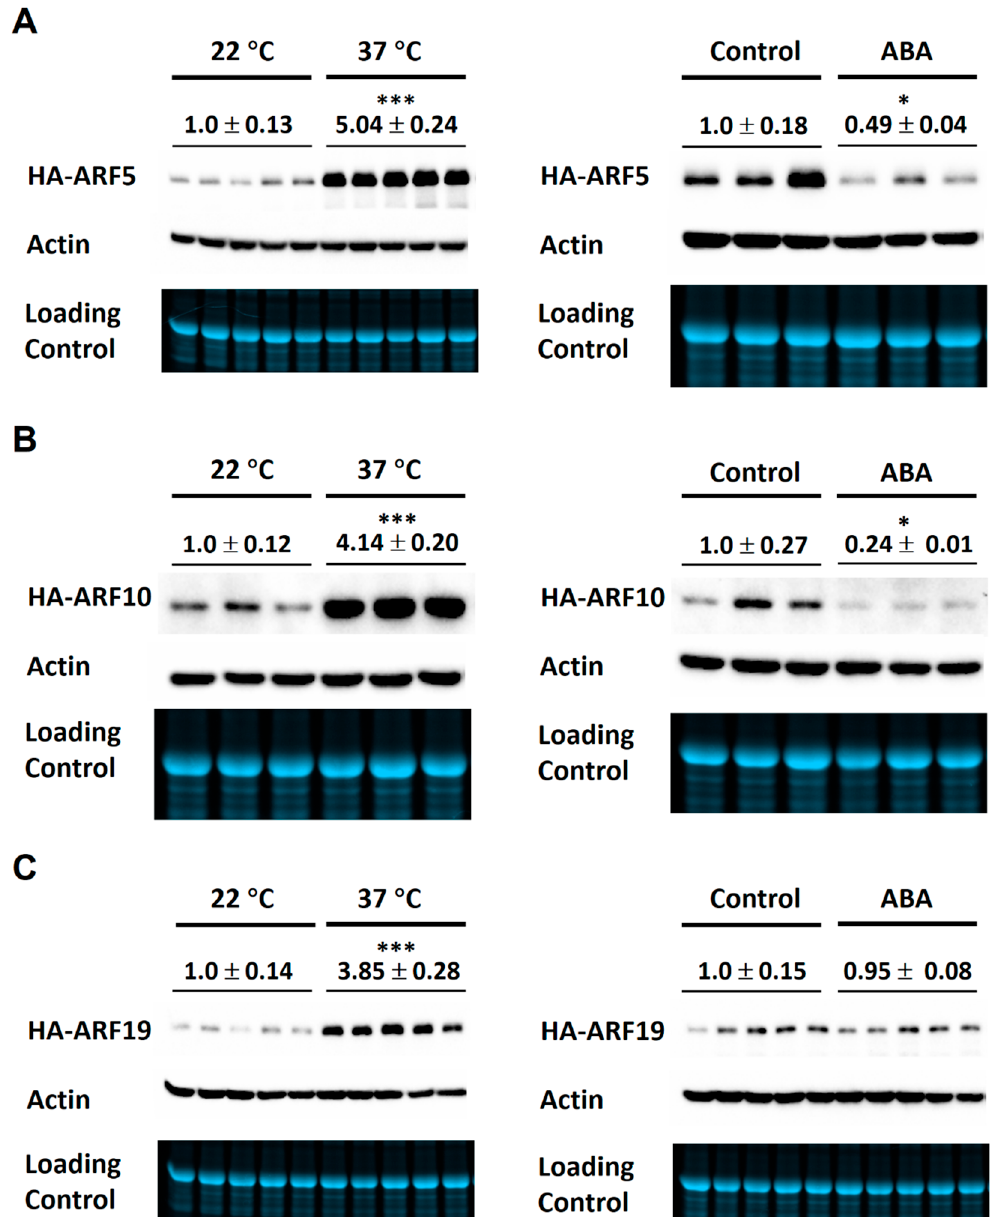
Figure 5. Effects of high temperature and ABA on the expression of ARF5 , ARF10 , and ARF19 . Transgenic seedlings of HA-ARF6 , HA-ARF10 , and HA-ARF19 were grown vertically in Petri plates. For temperature treatments, seedlings (10-day old) in the plates were treated directly at the indicated temperatures for 8 h. For ABA treatments, seedlings were transferred to new plates containing a filter paper and 5 mL half-strength MS with or without 50 µ M ( + )-ABA. Each plate had about 25 seedlings. After the treatment, protein samples were used (30 µ g per lane) in electrophoresis and western blotting. In each subfigure, the first row shows the western blot with an anti-HA antibody, the second row shows the western blot with an anti-actin antibody and third row shows gel image. The treatment conditions are indicated above the lanes, and relative level of ARF protein is shown below the treatment, based on three or five replicates. ( A ) HA-ARF5. ( B ) HA-ARF10. ( C ) HA-ARF19. The controls for ABA treatments used half MS medium plus 0.1% ethanol. Student’s t -test was used to determine the di ff erence between the treatment and control. The sign above the average value indicates a significant di ff erence from the control: * p < 0.05, *** p < 0.001.